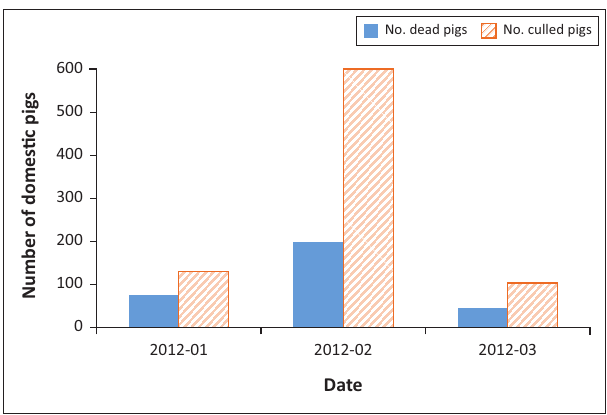
FIGURE 2: Number of domestic pigs affected per month during the 2012 African swine fever